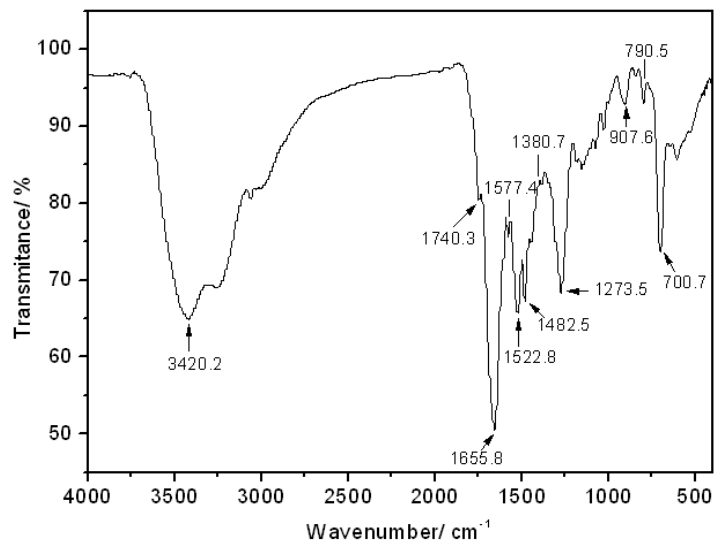
Figure 1. The FTIR spectra of N, N, N, N' -Tetra(benzoyl) ethylene diamine tetraacetic acid dihydrazide.